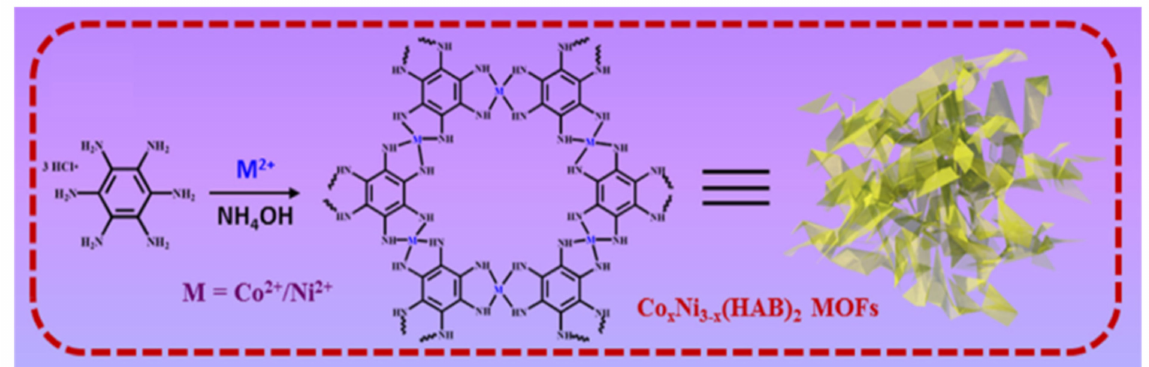
Figure 19. Preparation of Co x Ni 3-x (HAB) 2 MOF. Reproduced with permission from [57].